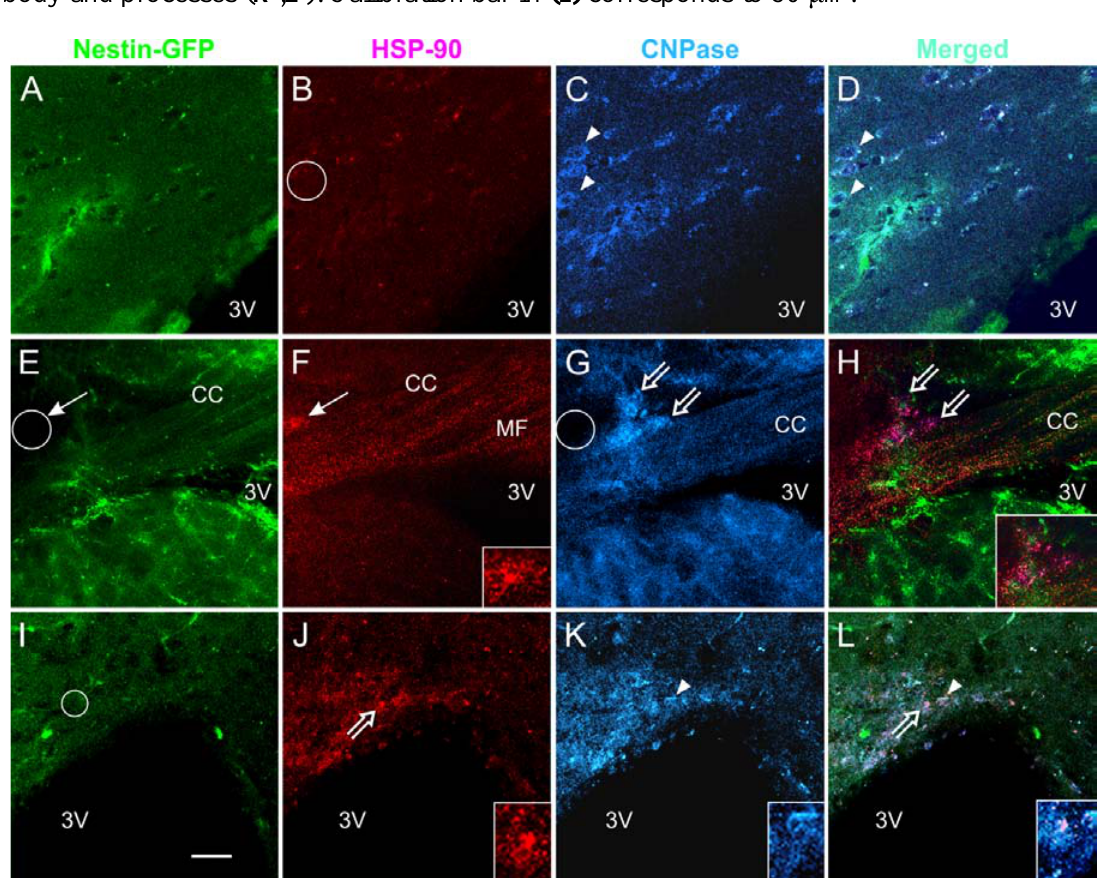
Figure 6. Acute NMDA exposure elicits the expression of HSP-90 in the CC and TSC1 neutralizes the NMDA effect. Coronal brain slices 300 μm thick were used for the acute treatment of NMDA alone or in slices pre-incubated with TSC1. After electrophysiology, slices were fixed and immunolabeled for the cell stress marker HSP-90 and the OL marker CNPase. ( A – D ) representative views of untreated slices, neither nestin ( A ) nor CNPase-expressing cells ( C -arrowheads) were labeled for HSP-90 ( B -circle). ( D ) merged image. After acute NMDA, CNPase-positive OL expressed HSP-90 ( E – F ). Moreover, cells that were not labeled for either of the two markers also expressed HSP-90 ( F , G -thin arrows and circle). In slices pre-incubated with TSC1 followed by acute NMDA treatment (see methods for details) ( I – L ) the majority of CNPase-positive cells did not express HSP-90 ( K ). Nestin-positive cells did not express HSP-90 in the presence of TSC1 ( I -circle). Some cells co-expressed CNPase and HSP-90 ( J , K and L -open arrows). Insets show higher magnification views of the cells pointed by open arrows in ( J) and ( L ). Arrowhead points to a CNPase-positive cell ( K ) that co-expresses HSP-90 ( L ). The inset in ( J ) shows an example on the colocalization of both HSP90 and CNPase both, in the cell body and processes ( K , L ). Calibration bar in (I) corresponds to 50